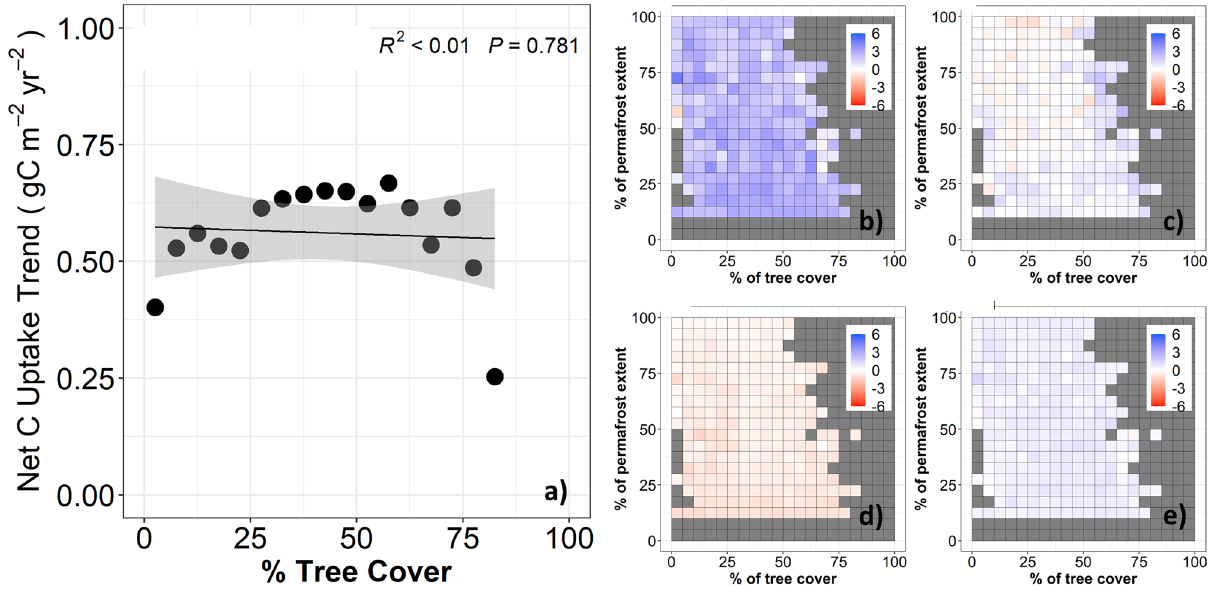
Fig. 4 | DGVMs cannot capture the decreasing trend of net CO 2 uptake along the NHL tree cover gradient, mainly because the DGVMs failed to simulate increased CO 2 emission in the LGS. a Correlation between trends of net CO 2 uptake with tree cover using the TRENDY ensemble. b – e show net CO 2 uptake in